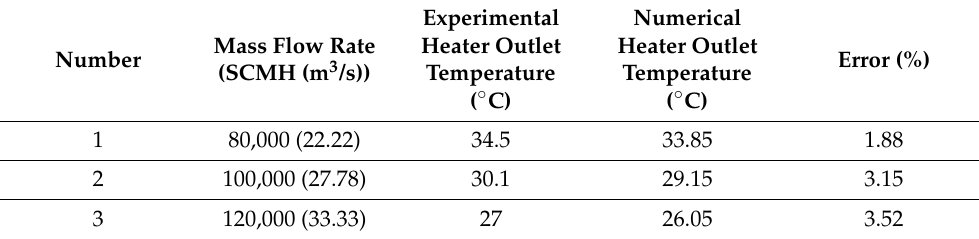
Table 5. The results of the Validation analysis.